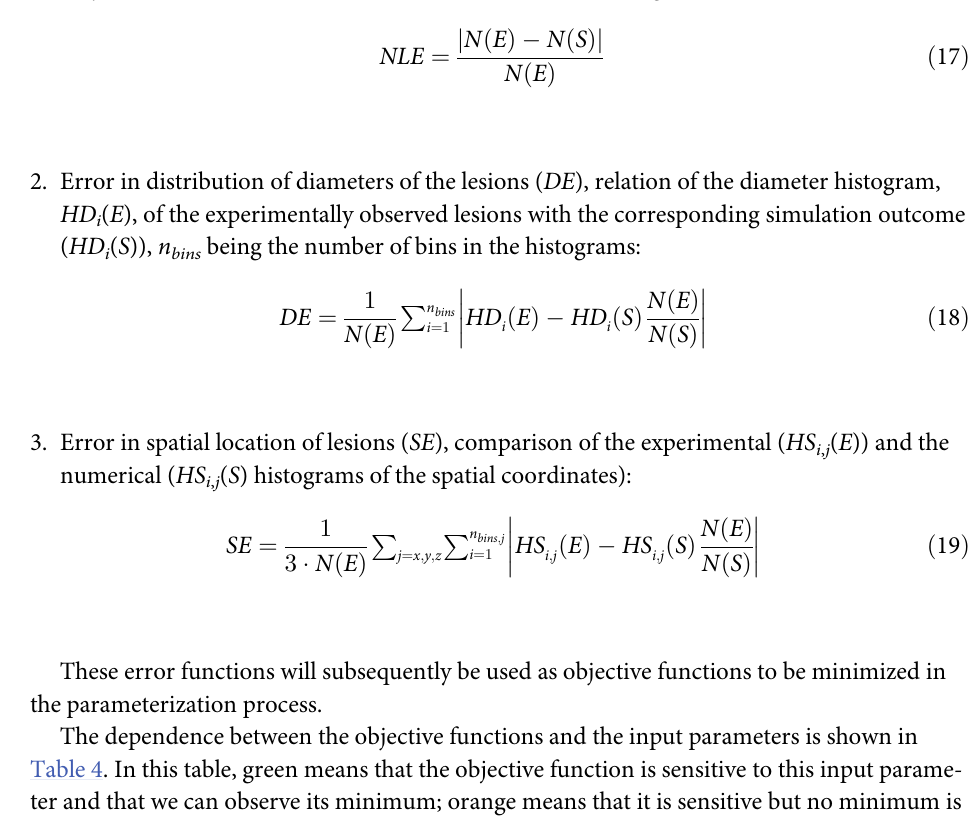
Table 4. Sensitivity of the error functions (NLE, DE, and SE) to the three parameters explored ( β , ρ and r max ). Error function β ρ r max Number of lesions error (NLE) IM IM IM Diameter error (DE) NM NA IM Spatial error (SE) IM NA NA In green (IM), error functions that are affected by these parameters for which a minimum can be identified; in orange (NM), those that are affected but do not present a distinguishable minimum; in red (NA), those functions that are not affected by the parameter.